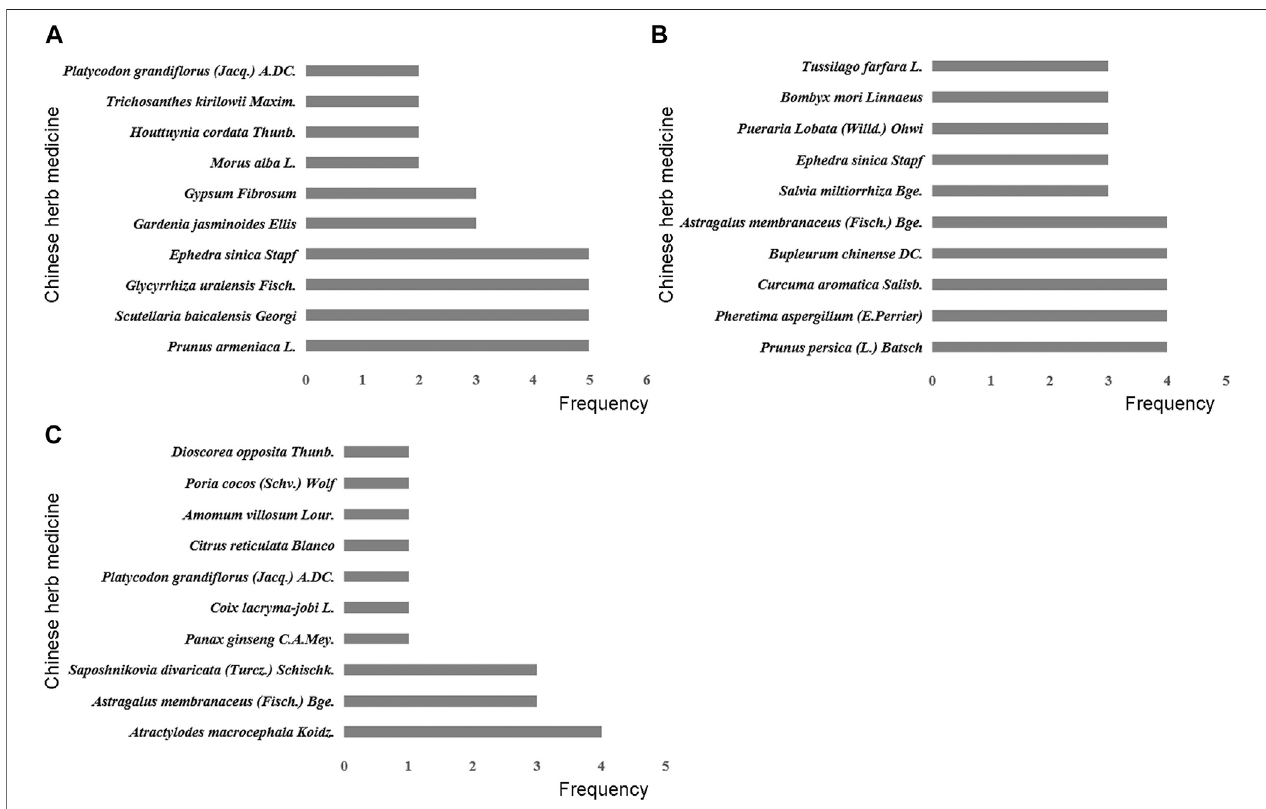
FIGURE 7 | Frequency distribution of Chinese herb medicines in different traditional Chinese therapies. (A) Removing heat-phlegm and toxicity therapy. (B) Promoting blood circulation therapy. (C) Invigorating Qi and consolidating super fi cies therapy.